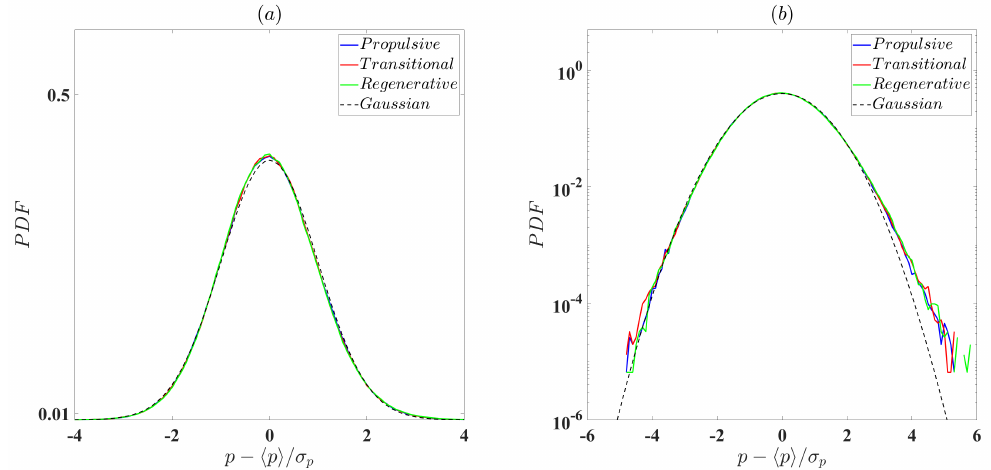
Figure 12. Probability density function of the broadband component of pressure signals for each operational condition. The PDFs are reported in both linear ( a ) and logarithmic scales ( b